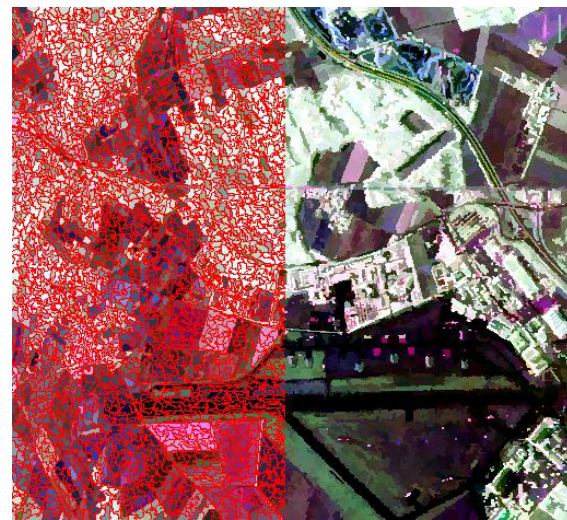
Figure 4. Segmentation result of P-BPT using the NoR-based pruning